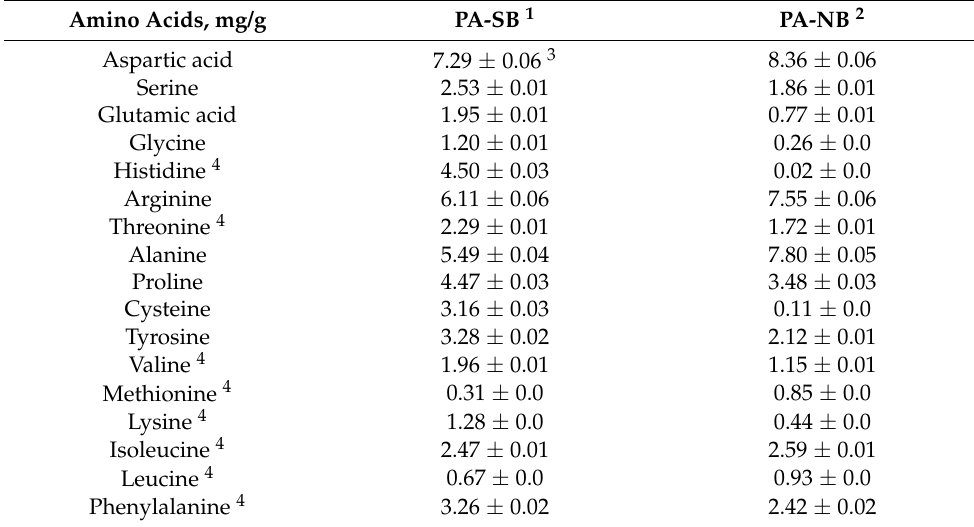
Table 4. Amino acid composition of Physalis alkekengi fruit (on a fresh weight basis). Amino Acids,